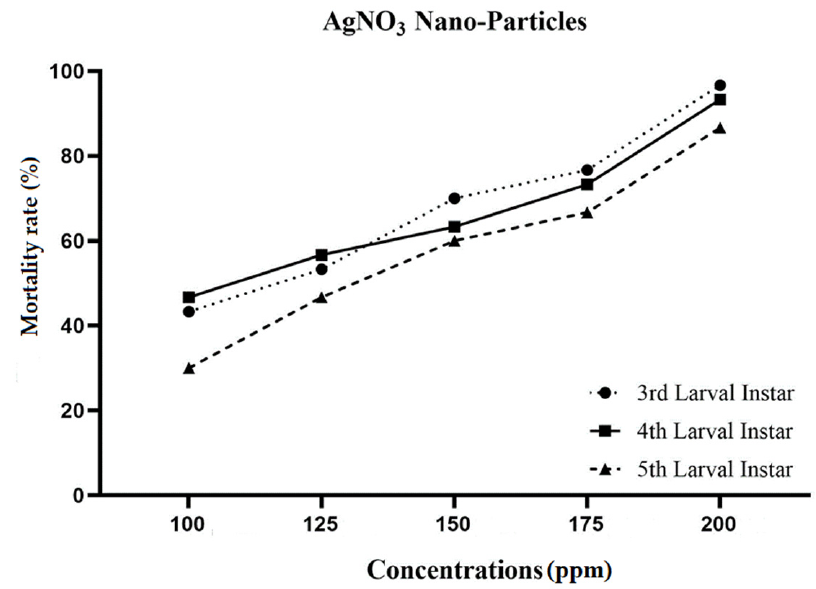
Figure 1. Effect of Ag NPs on the mortality percentage of H. armigera. In the case of zinc oxide NPs, maximum mortality was observed in third instar larvae at 200 ppm. Zinc oxide NPs caused different percent mortalities at different concentrations in third instar larvae, e.g., 33%, 47%, 60%, 73% and 83% mortality at 100, 125, 150, 175 and 200 ppm, respectively. Similarly, on the fourth larval instar 43%, 53%, 67%, 72% and 80% mortality was recorded at 100, 125, 150, 175 and 200 ppm, respectively. Likewise, in the fifth larval instar, 13%, 37%, 47%, 60% and 70% mortality was recorded at 100, 125, 150, 175 and 200 ppm, respectively. Maximum mortality was observed at the highest concentration of 200 ppm in the third and fifth instar larvae. Ag NPs were more toxic for H. armigera as compared to zinc oxide nanoparticles (Figure